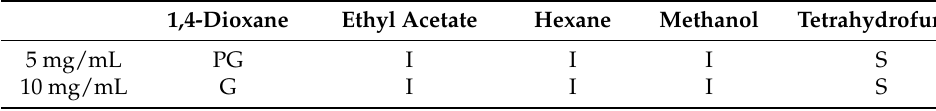
Figure 2. ( a ) Differential scanning calorimetry thermogram of 2ECh (inset: polarized optical microscopy image of 2ECh at 250 °C). ( b ) photograph of 2ECh at 250 °C injected in 8- μ m cell. Table 1. Gel-formation tests for 2ECh in various solvents.